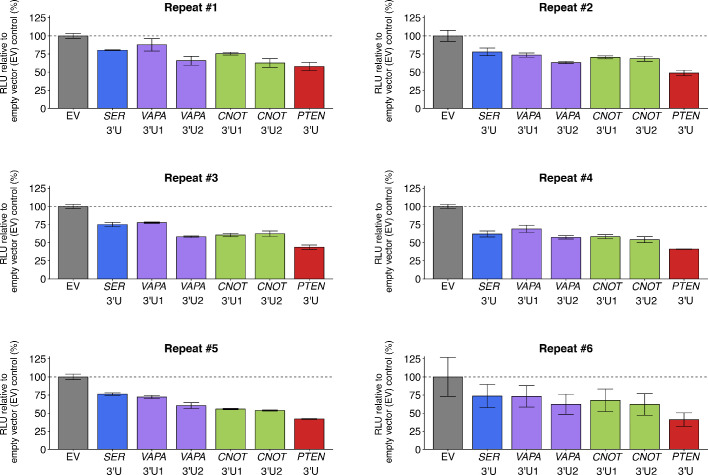
Individual repeats of luciferase-PTEN 3’UTR reporter assay in DU145 cells co-transfected with 3’UTR of PTEN ceRNAs.This is the same experiment as Figure 2. Independent biological repeats of luciferase reporter assay. Relative luminescence unit (RLU) is presented for each condition relative to the EV condition. Means reported and error bars represent SD from three technical replicates. Additional details for this experiment can be found at https://osf.io/mryvq/.